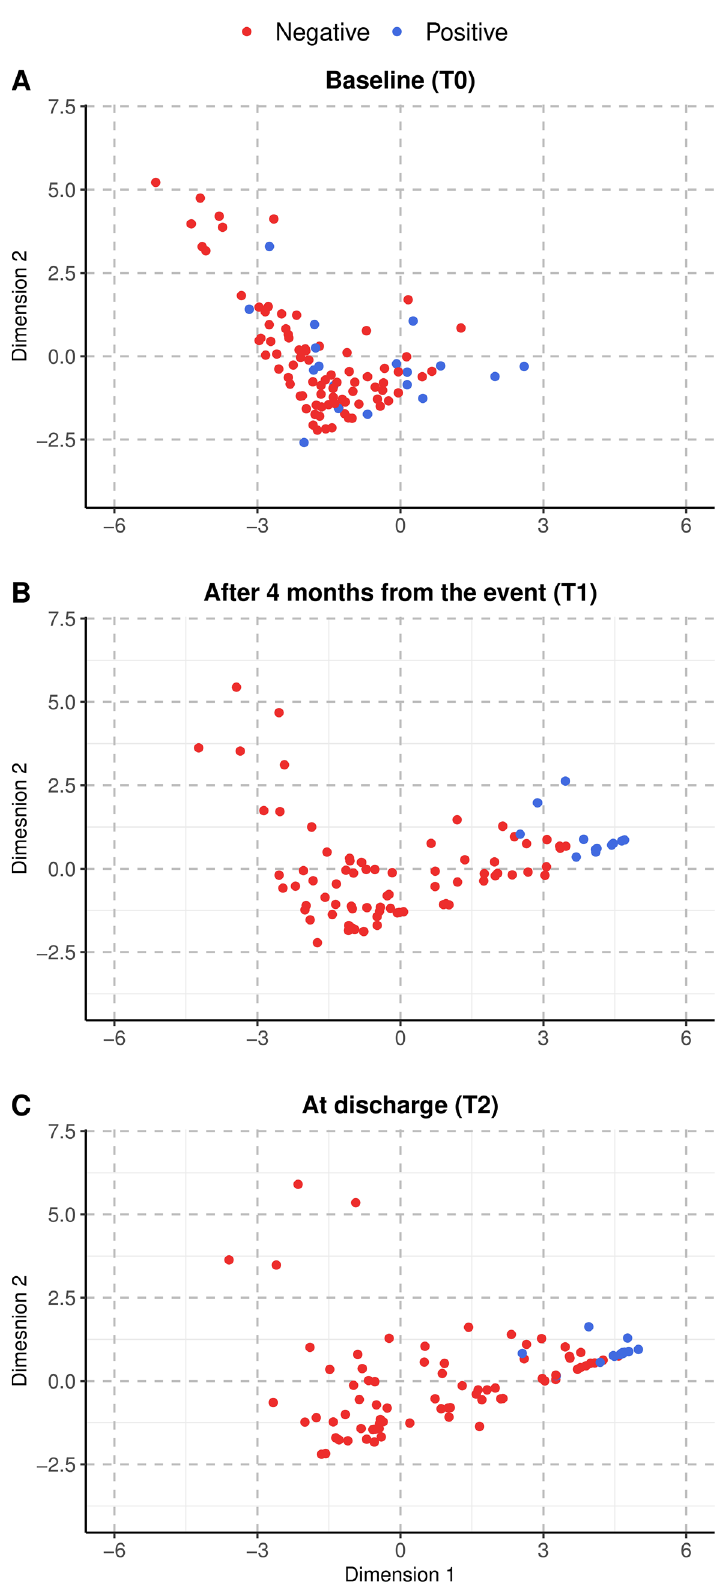
Figure 2. Patients’ scores on the two PCA dimensions at baseline (T0), panel ( A ); 4 months after the event (T1), panel ( B ); at discharge (T2), panel ( C ), for individuals with Positive (blue dots) and Negative (red dots)